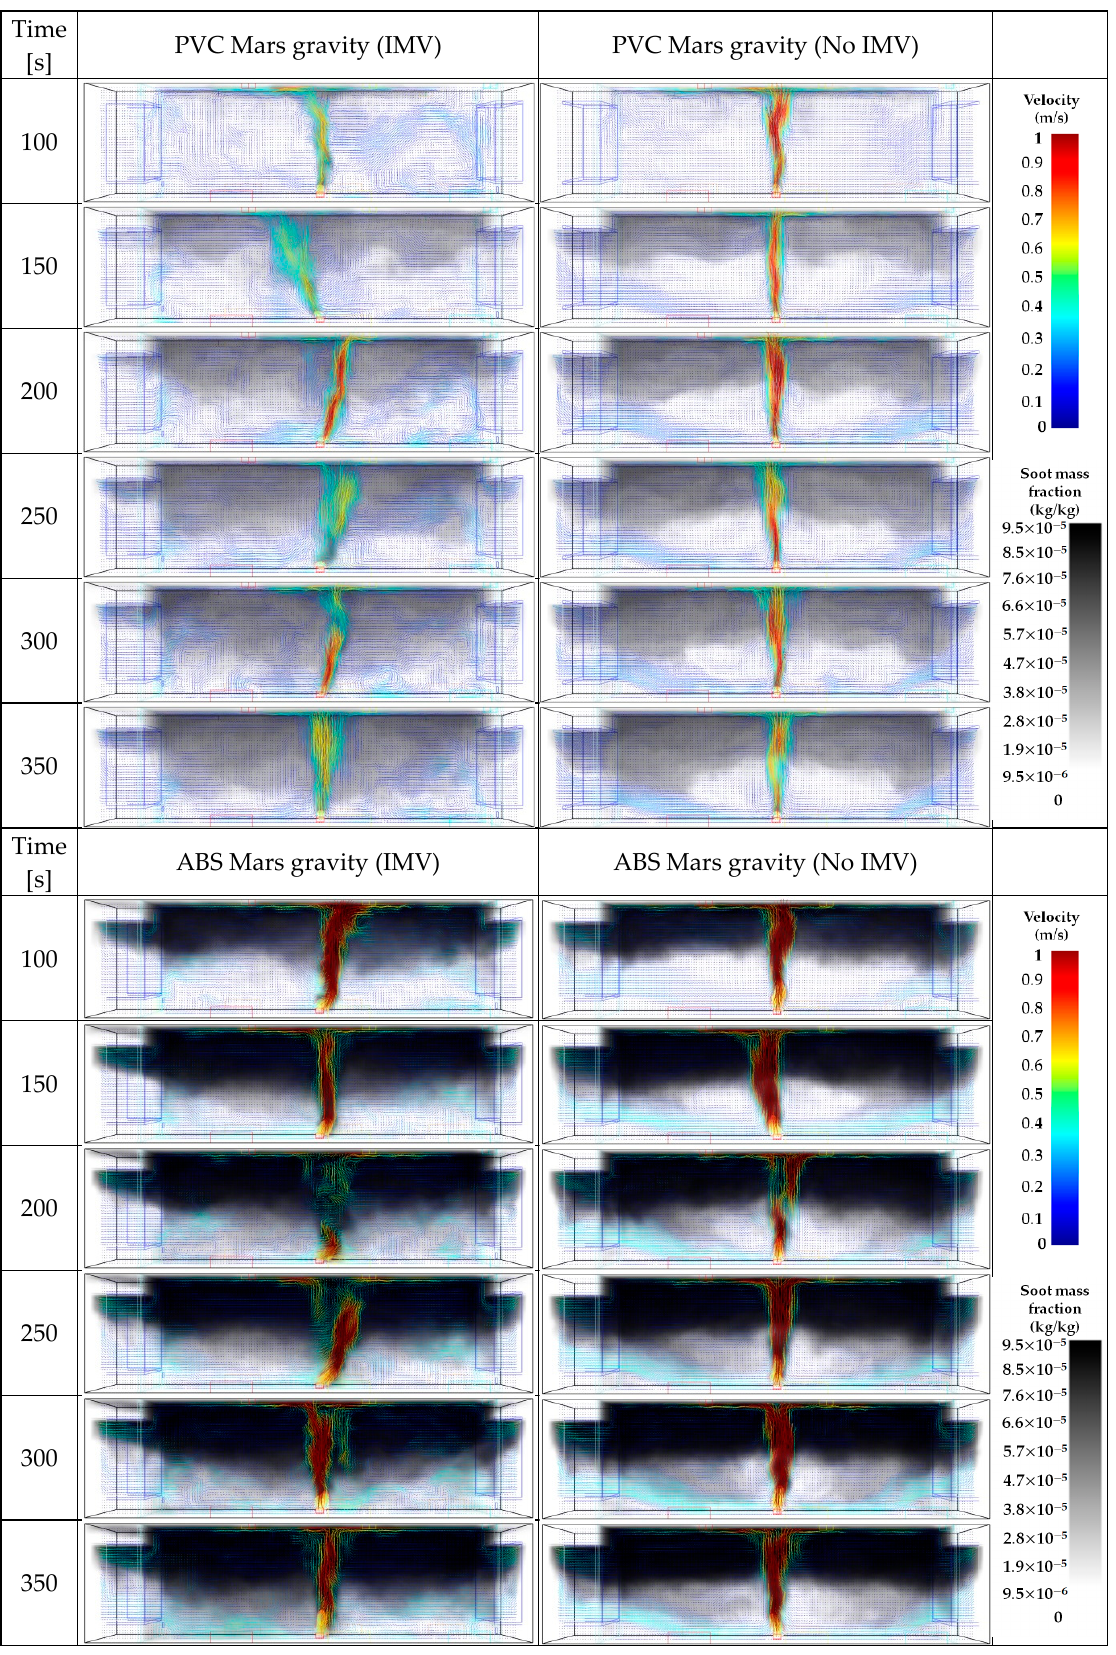
Figure 8. Smoke mass fraction with respect to time of PVC and ABS with and without IMV under Mars gravity.